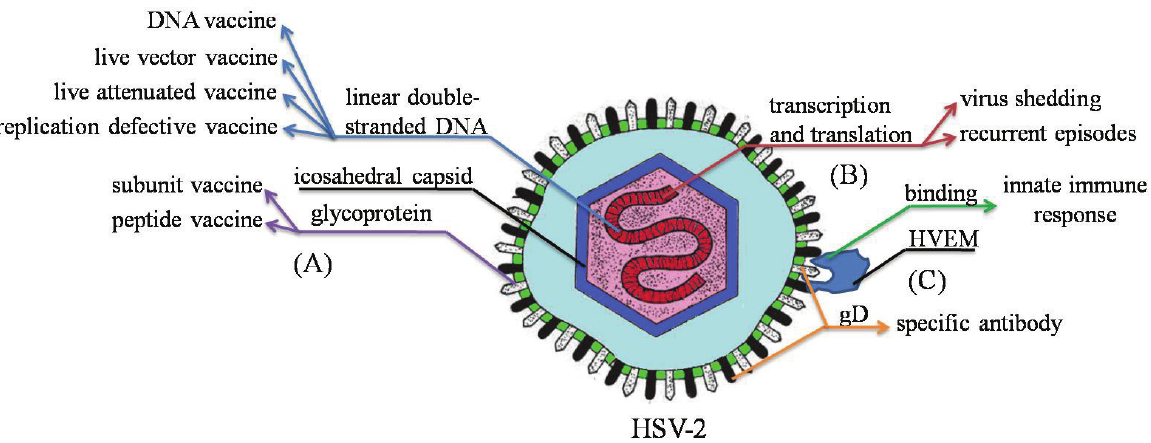
Figure 1. Illustration of pathogenesis and immune responses of HSV-2 in vaccine development. ( A ) HSV-2 glycoproteins, especially gB and gD, are widely used to develop subunit vaccine and peptide vaccine. DNA has also been frequently used for vaccine development; ( B ) The transcription and translation of the genes lead to HSV-2 shedding and recurrent episodes; ( C ) The ability of gD to induce specific antibody is the strongest. The combination of gD with HVEM triggers immediate innate immune response, which leads to subsequent adaptive immune